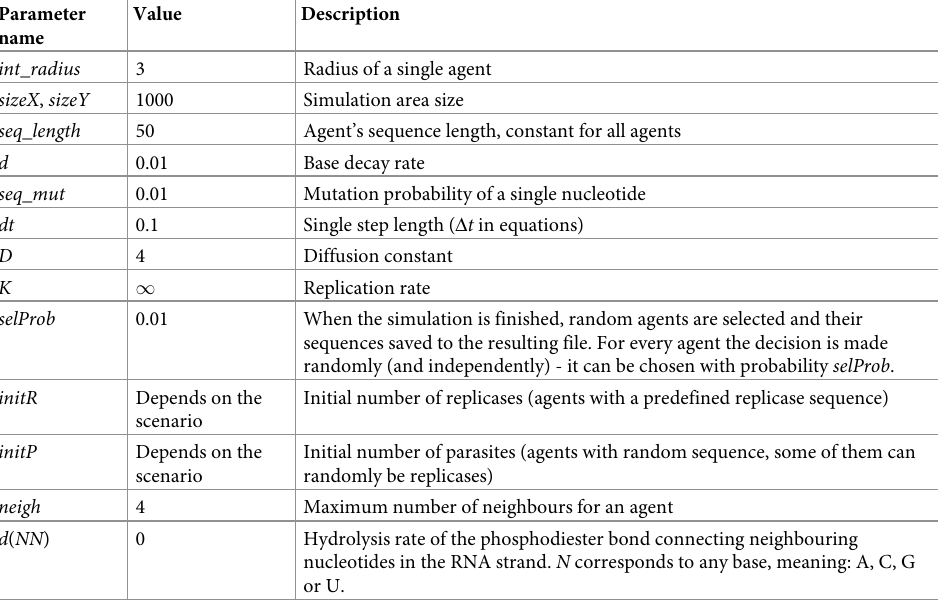
Table 1. Parameters used in the simulation. They are global constants that are used extensively in the